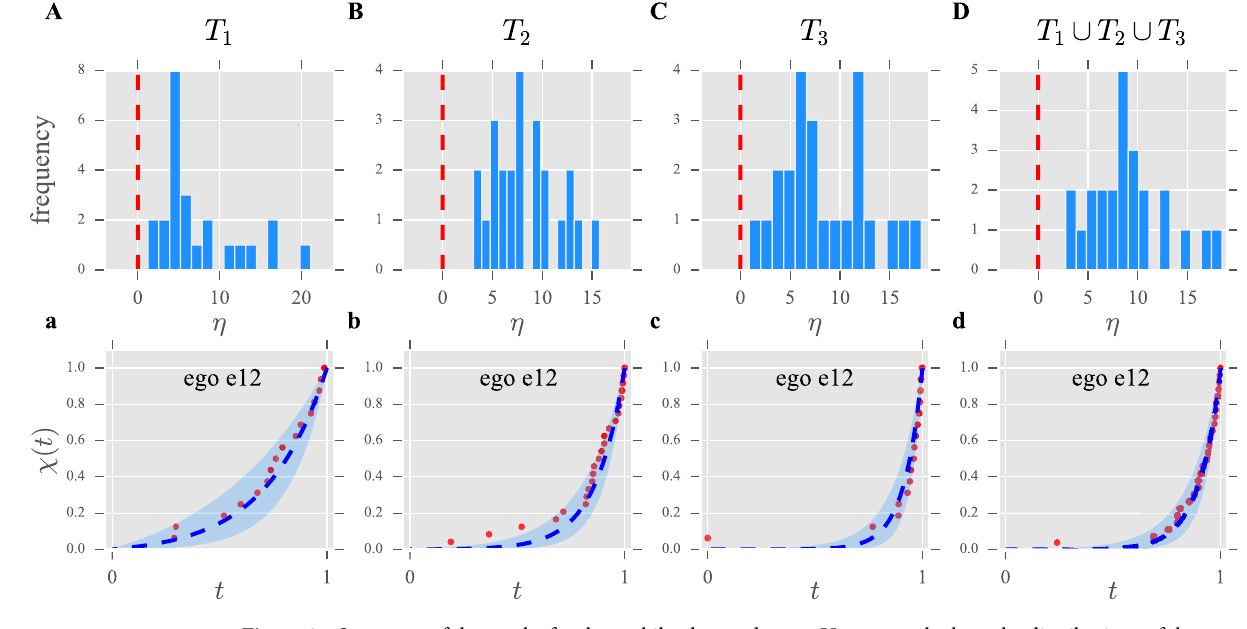
Figure 2. Summary of the results for the mobile phones dataset. Upper panels show the distributions of the parameter estimates for the different time windows (see “Mobile phones dataset” section for details). The red, dashed lines mark the change from standard ( η > 0 ) to inverse ( η < 0 ) regimes. ( A ) Distribution of the parameter estimates for the first time window (months 1–6); mean = 7.52 , median = 5.32 , std = 5.07 . ( B ) Distribution of the parameter estimates for the second time window (months 6-12); mean = 8.32 , median = 8.00 , std = 3.31 . ( C ) Distribution of the parameter estimates for the second time window (months 12-18); mean = 8.48 , median = 7.00 , std = 4.56 . ( D ) Distribution of the parameter estimates for the full time window (months 1-18); mean = 9.07 , median = 8.75 , std = 3.92 . Lower panels show the fittings for the same individual (ego “e12”) at each of the time windows. Solid dots represent experimental data, blue dashed lines represent the graph of χ( t ) in Eq. (9) with the corresponding estimated parameter, and shaded regions show the 95% confidence interval for that estimate (see “Bayesian estimate of the scaling parameter” section). a Example of fitting for an individual (“e12”) in the first time window. Estimated η = 3.55 , 95% confidence interval (1.82, 5.77), ˜ L = 21 . ( b ) Example of fitting for an individual (“e12”) in the second time window. Estimated η = 7.38 , 95% confidence interval (5.18, 10.34), ˜ L = 33 . ( c ) Example of fitting for an individual (“e12”) in the third time window. Estimated η = 11.79 , 95% confidence interval (7.87, 17.69), ˜ L = 23 . ( d ) Example of fitting for an individual (“e12”) in the full time window. Estimated η = 9.77 , 95% confidence interval (6.83, 13.95), ˜ L = 30 . A comprehensive set of figures, including fittings for every subject at all time windows, is available in the Supplementary